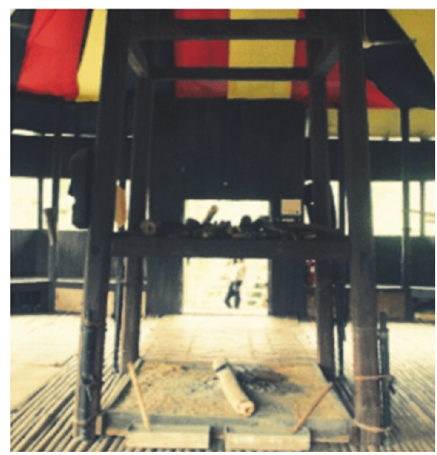
Figure 3: Human skulls were place above the fireplace in the Baruk (warrior